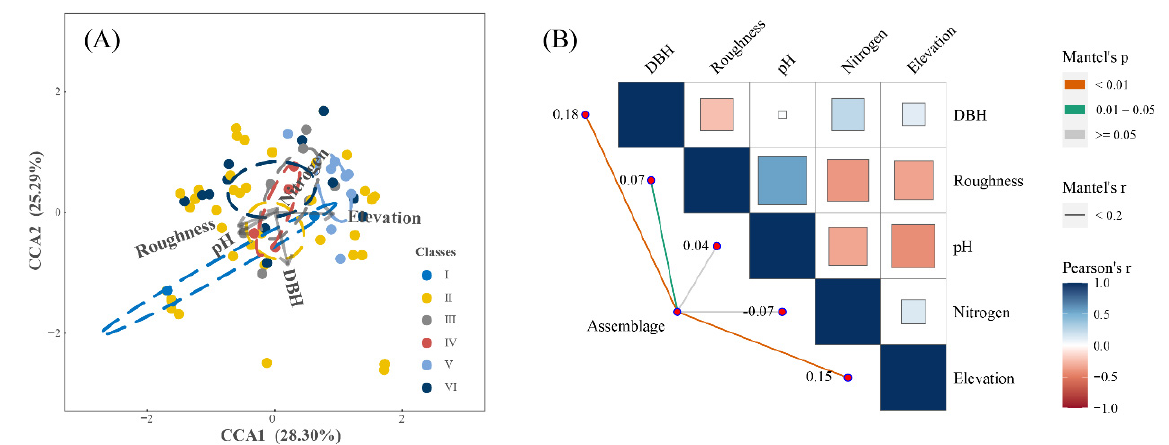
Figure 5. Relationship between bryophyte assembly and environment. ( A ) based on dissimilarities among different class (shown as letters I–VI corresponding to their classification) using CCA. The positions in ordination space are shown for 72 tree sites and environmental factors. The ellipses were calculated around barycenters with a confidence level of 0.95. ( B ) Pairwise comparisons of environmental factors are shown, with a color gradient denoting Pearson’s correlation coefficient. Edge color denotes statistical significance. pH, potential of hydrogen; DBH, diameter at breast height.